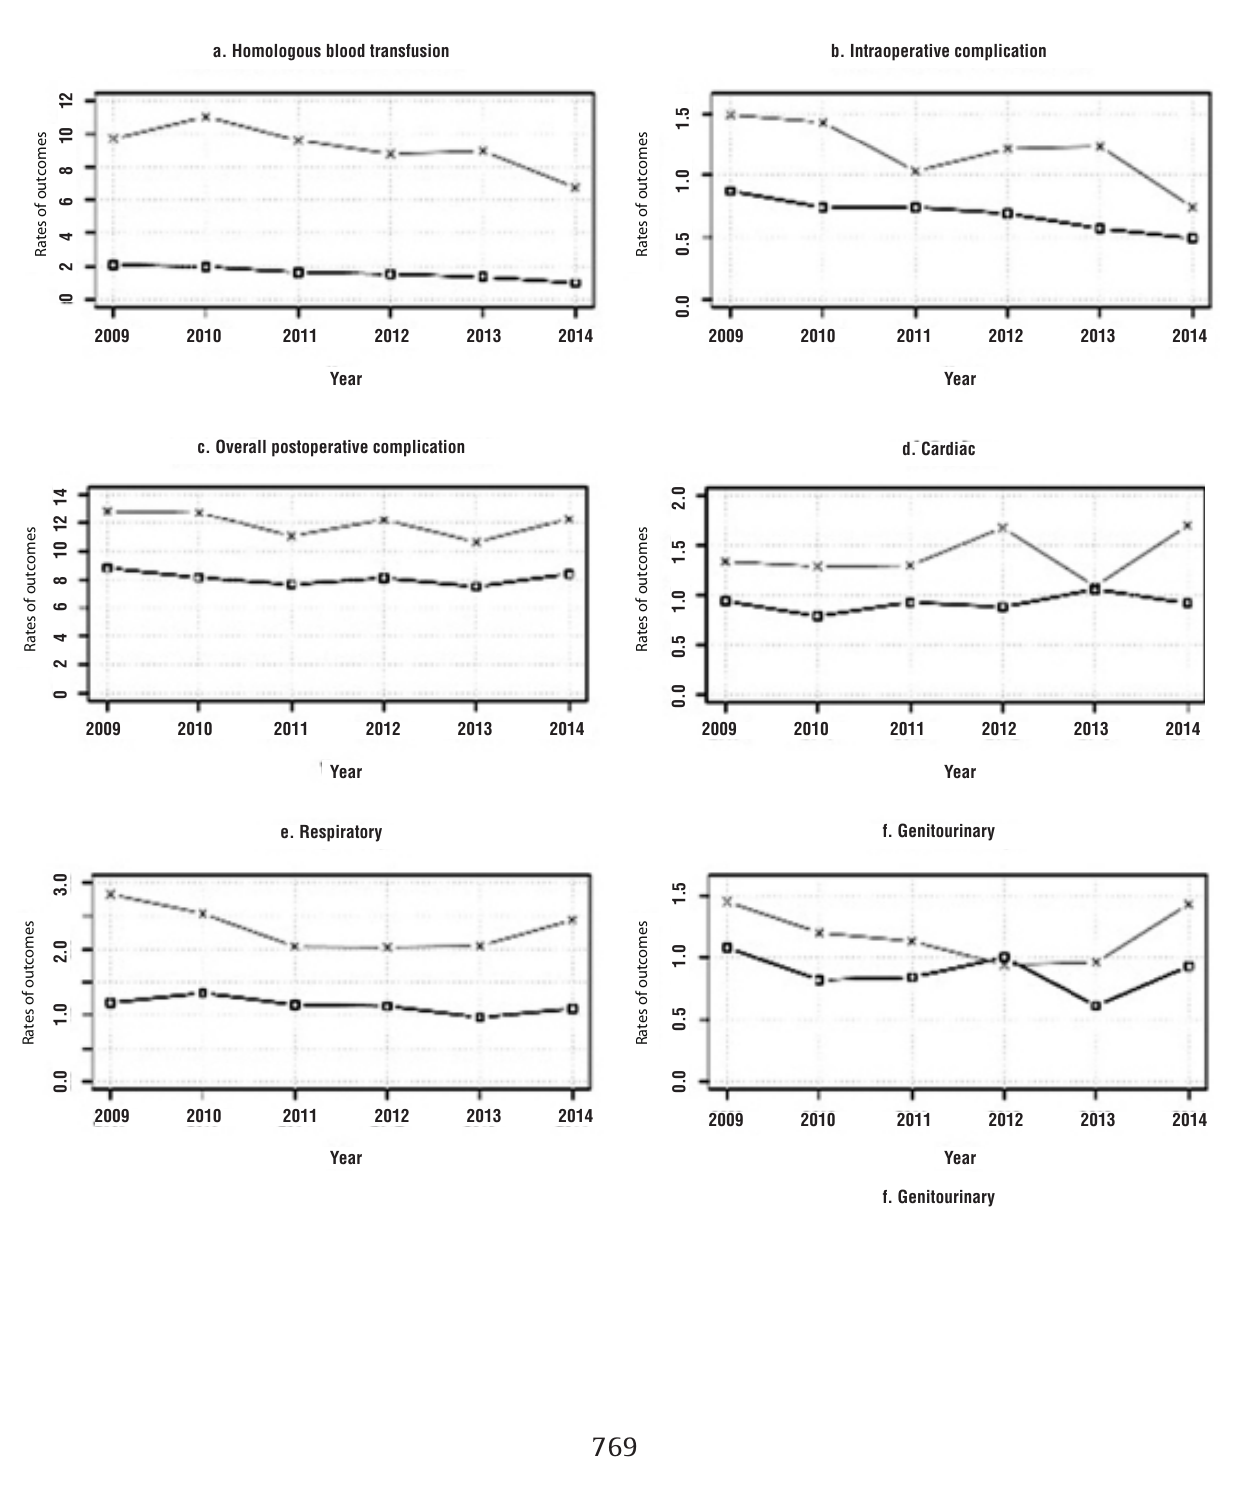
Supplementary Figure-1 - The incidence rates of the perioperative outcomes for the Robot-assisted Radical Prostatectomy group and the Open Radical Prostatectomy group from 2009 to 2014 (pre-propensity score-matched